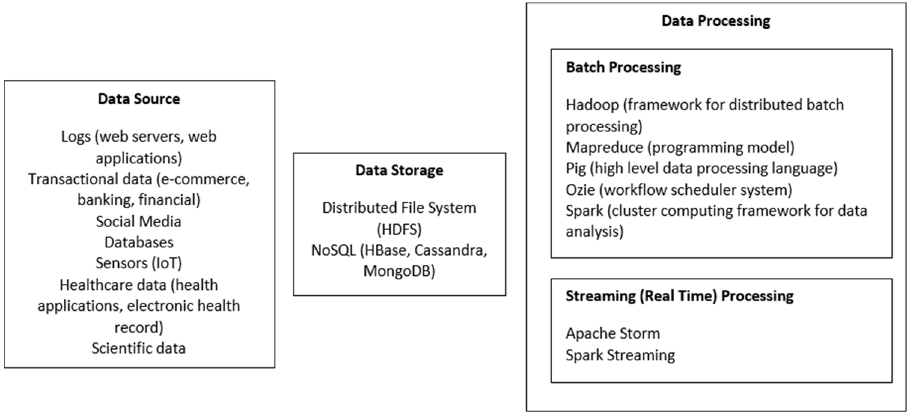
Figure 11. Some components of big data architecture.